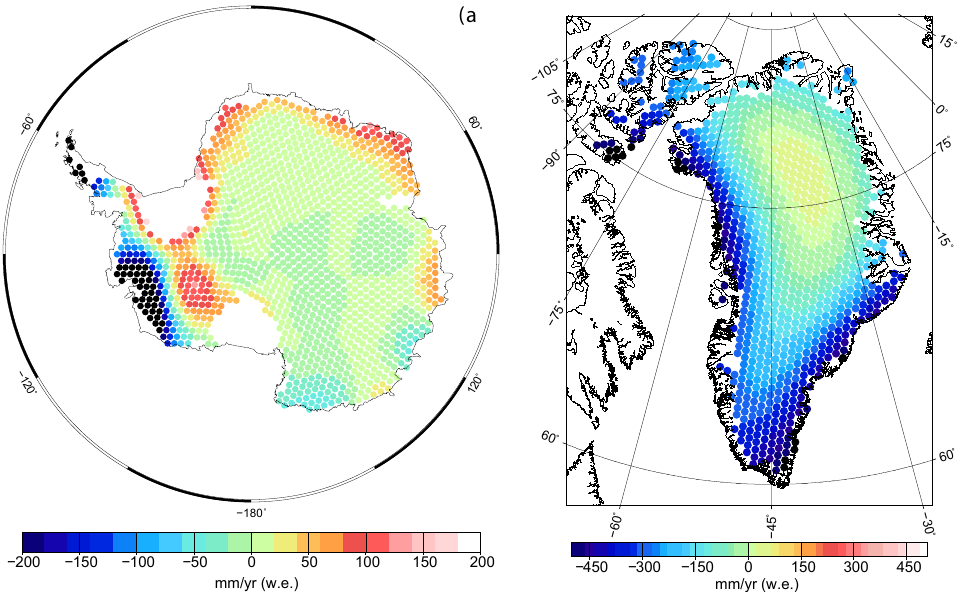
Fig. 2. Point mass solution for the trend in Antarctica (a) and Greenland (b) for the inversion method (Method 1). The mass points are inverted on icosahedron-based grids (Tegmark, 1996), using disks of about 40 and 20km radius for Antarctica and